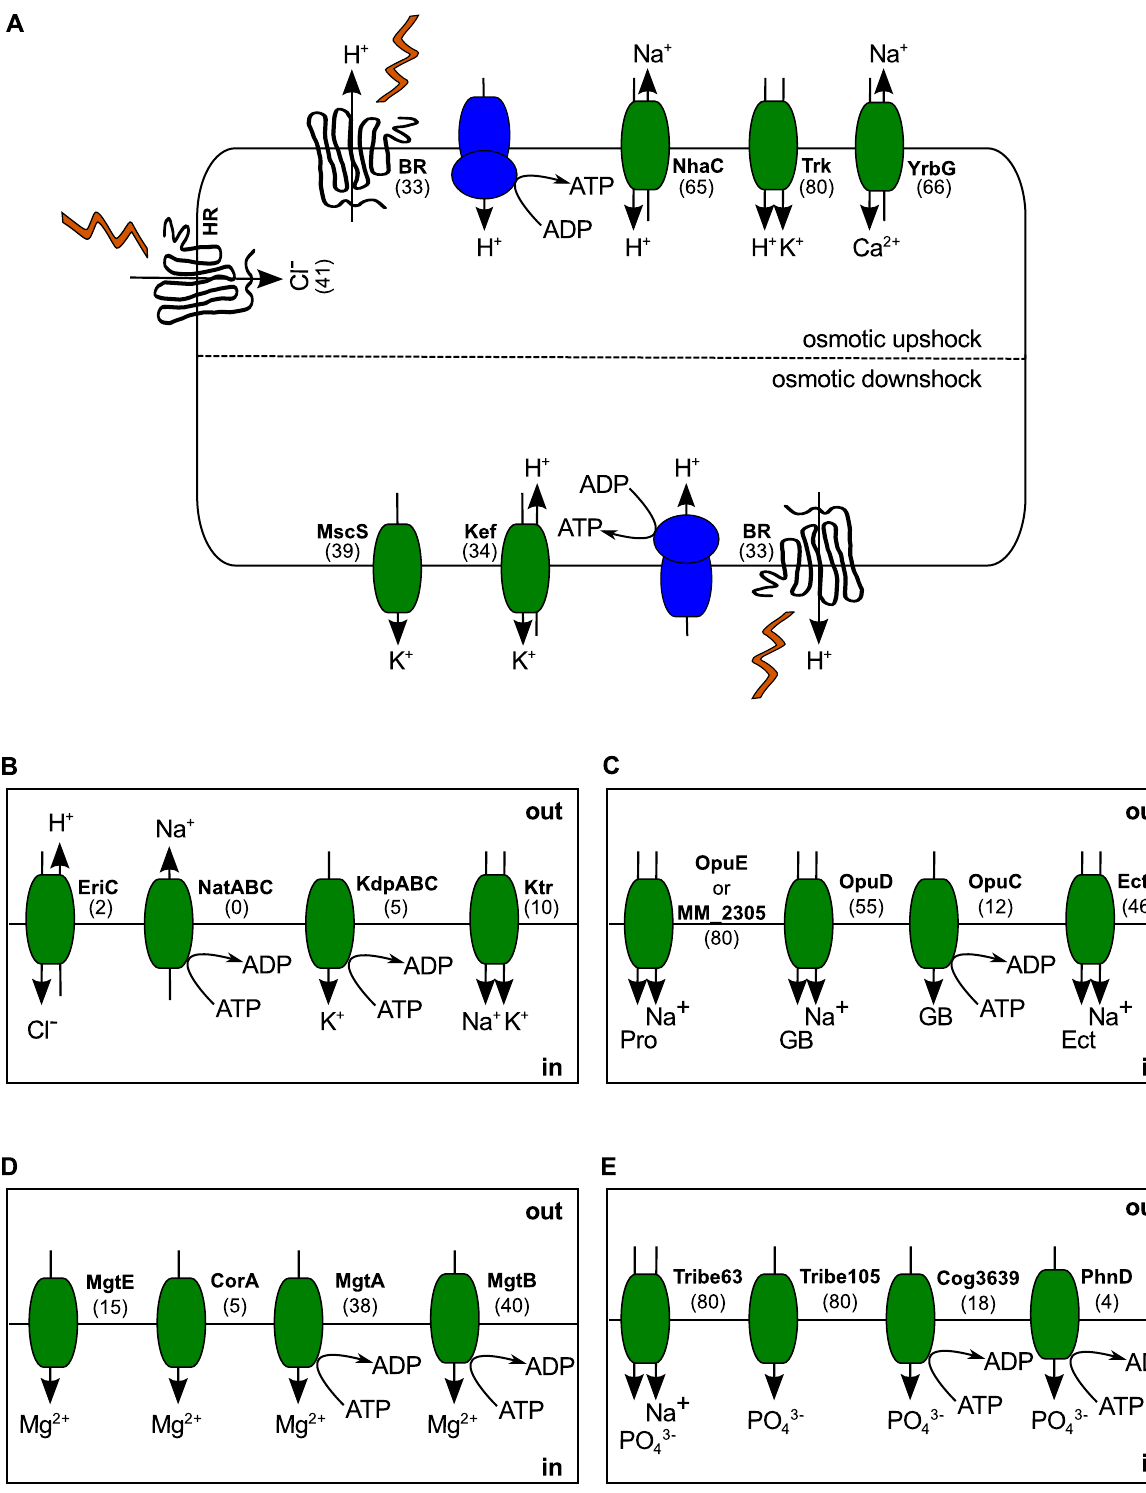
Figure 4. Haloarchaeal osmoadaptation. (A) Generalized model for osmoadaptation in the haloarchaea. During osmotic upshock, potassium is imported through Trk H + /K + symporters and Na + is expelled using a combination of NhaC H + /Na + antiporters and/or YrbG Ca 2 + /Na + antiporters. During osmotic downshock, excess potassium is removed through a combination of Kef H + /K + antiporters and the non-specific mechanosensitive channel MscS. (B) Ion transport strategies not generally encoded by the haloarchaea. Sodium export and potassium import using ABC transporters (NatABC and KdpABC) may be less energetically efficient than secondary transport systems. Use of Ktr K + /Na + symporters for potassium uptake would result in over-accumulation of sodium. (C) Compatible solute transport systems. Na + /proline symporters (OpuE and MM_2305) are ubiquitous in the haloarchaea. Glycine betaine uptake is mediated by OpuD through symport with sodium or, rarely, through the ABC transporter OpuC. The ectoine/